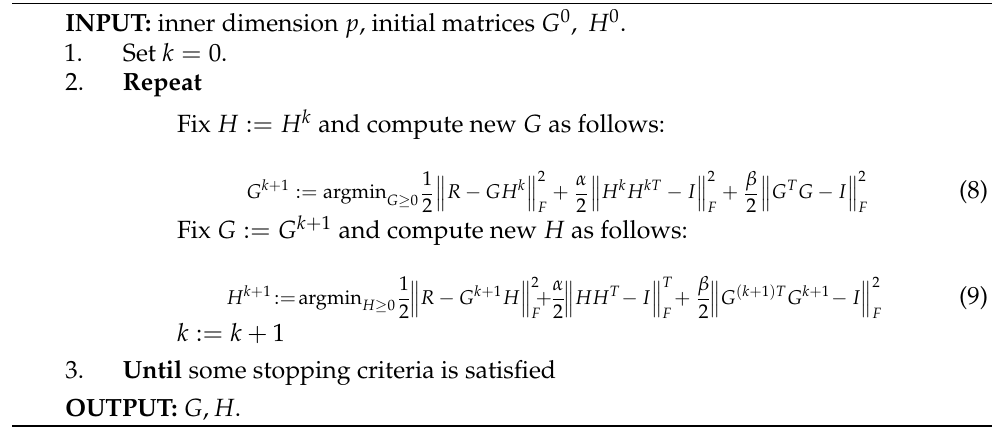
Algorithm 3: BCD method for